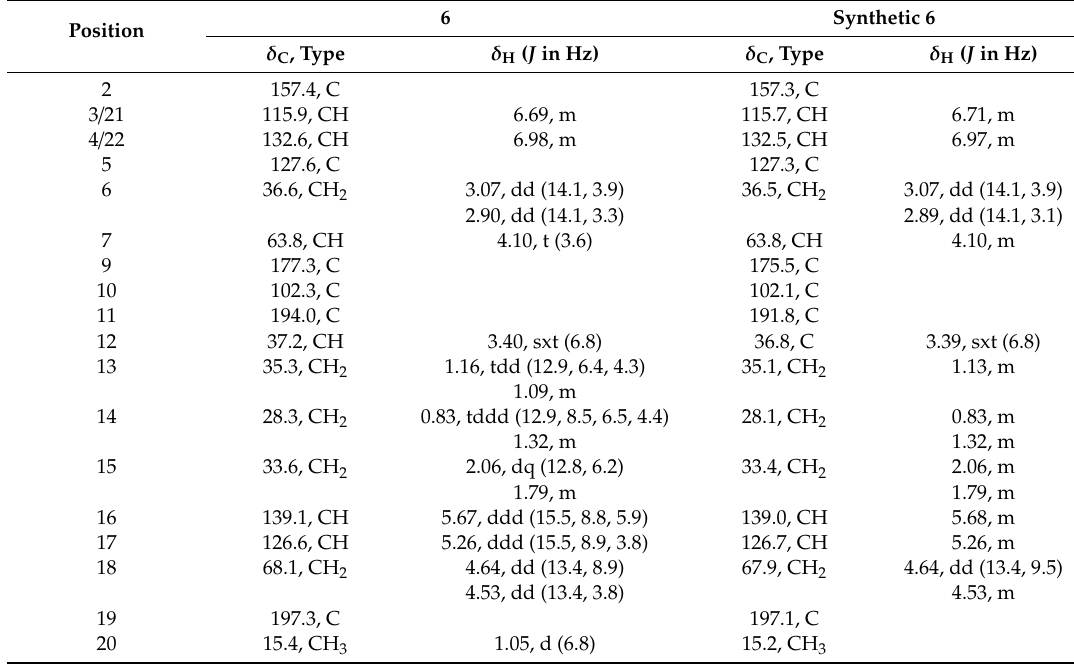
Table 1. 13 C and 1 H-NMR spectroscopic data ( 1 H 500 MH Z , 13 C 125 MH Z in Methanol- d 4 , δ in ppm) for isolated and synthetic compound 6 .